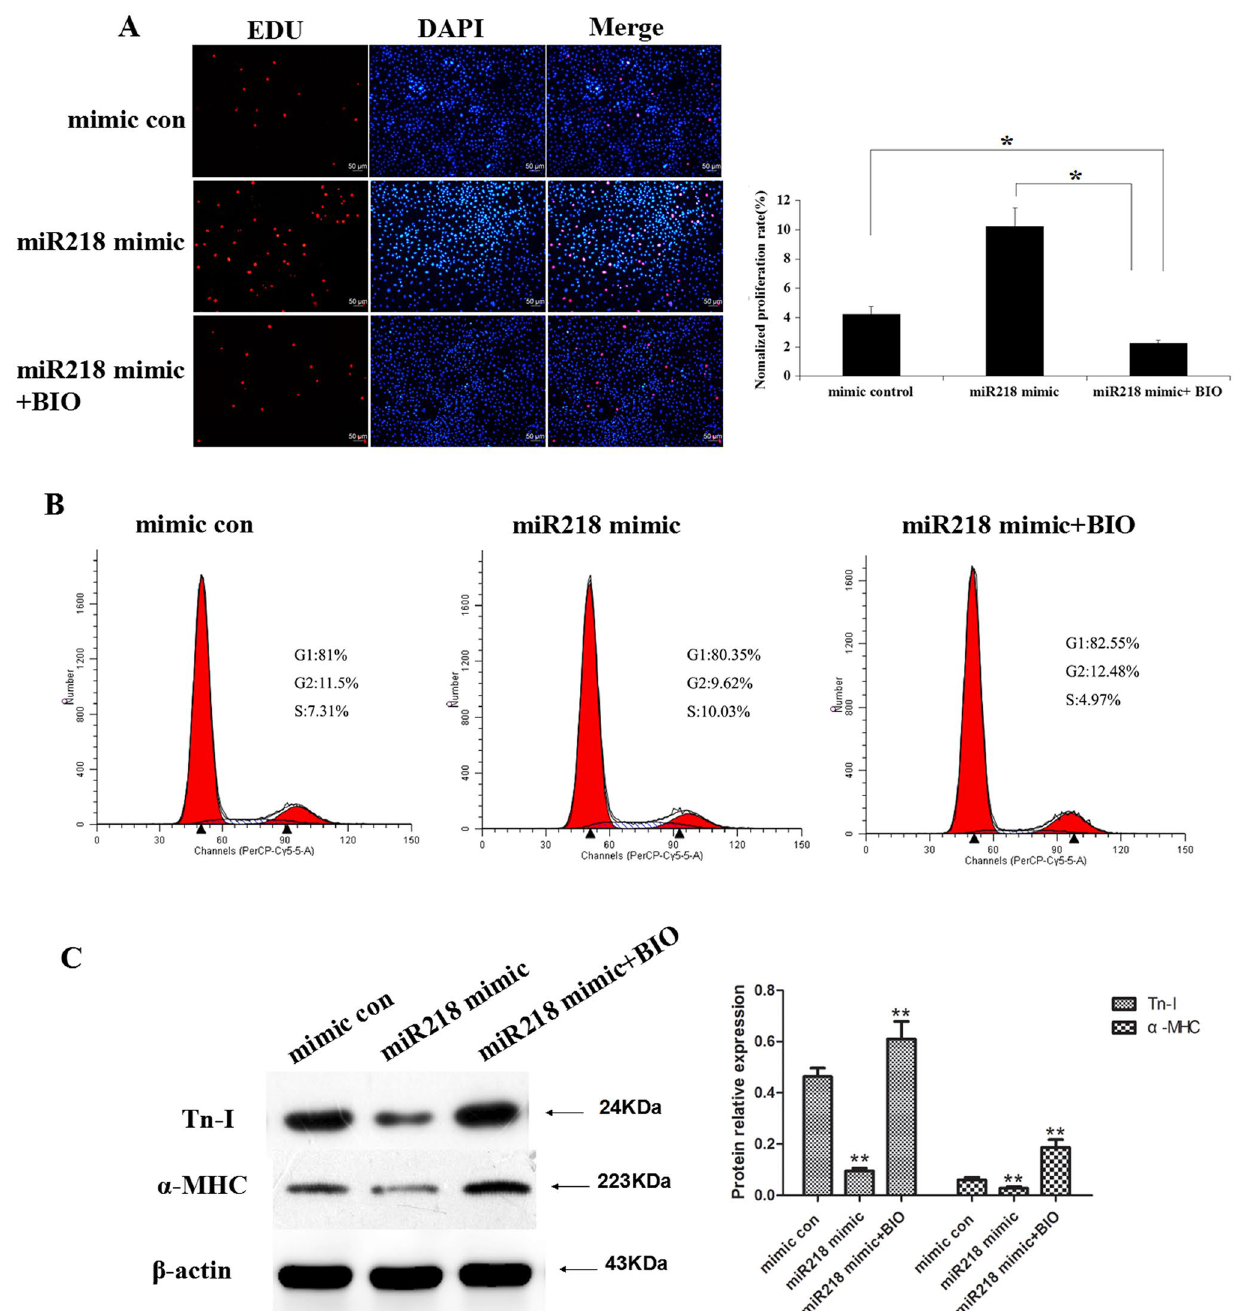
Figure 6. BIO restored the effects of miR218 on the proliferation and cardiac differentiation of CSCs. ( A ) Cells transfected with the miR218 mimic and treated with BIO were stained with EdU and Hoechst 33342. ( B ) Cell cycle distribution of the CSCs after the same treatment. ( C ) Western blot analysis of proteins from CSCs transfected with the mimic-control or the miR218 mimic or treated with the miR218 mimic and BIO and subsequently cultured in differentiation medium for 12